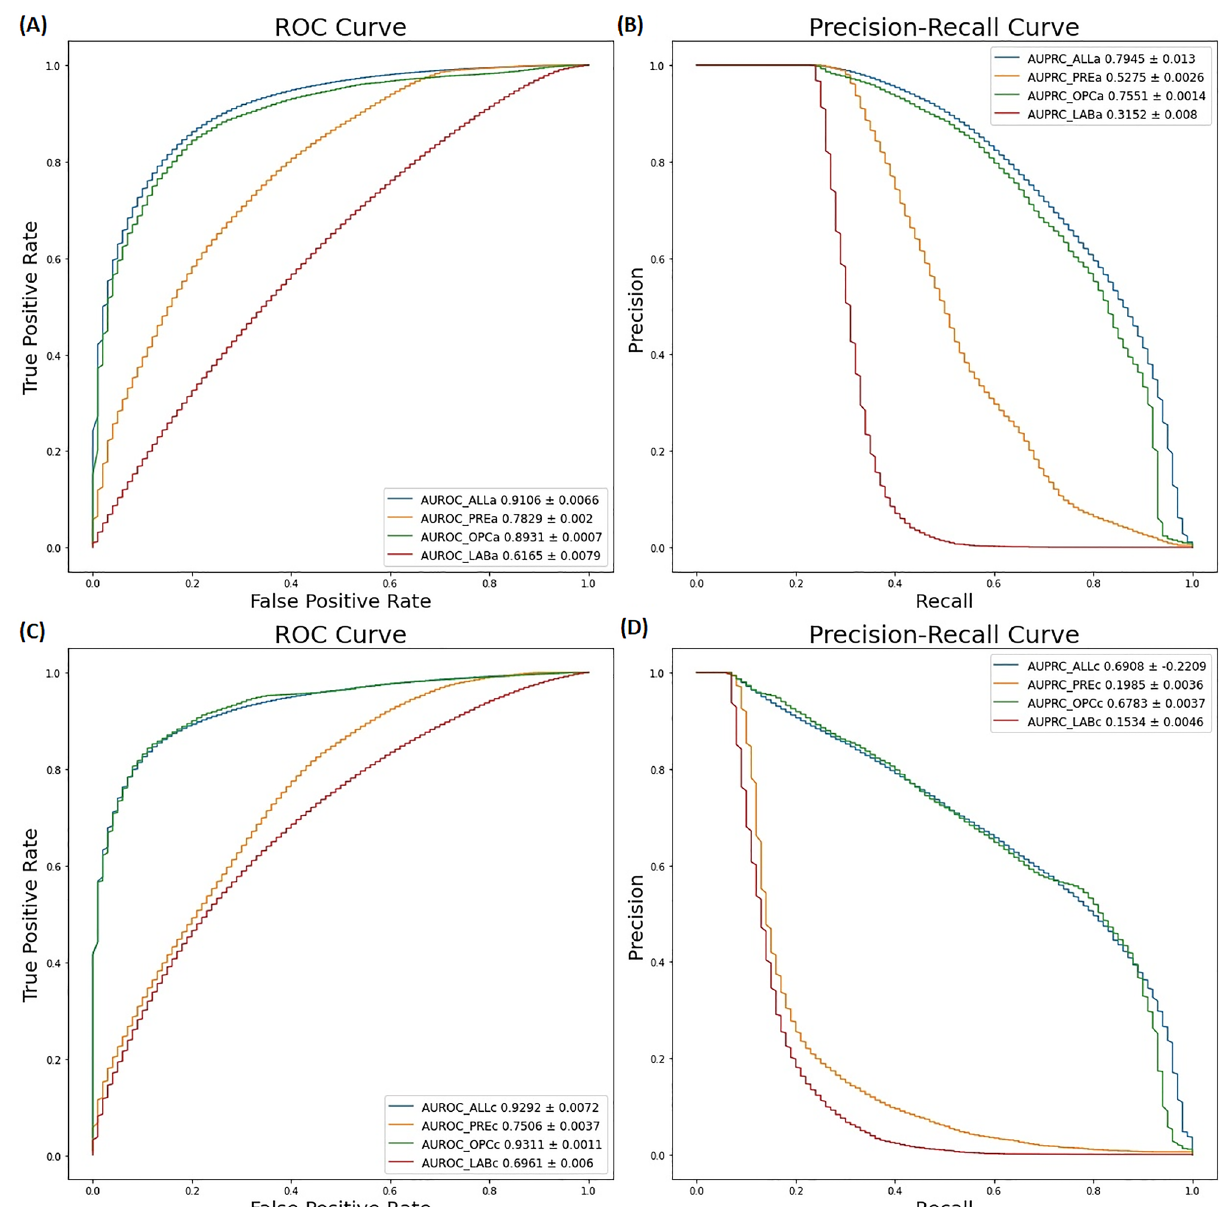
Figure 1. The predictive performance of the predictive models for several feature combinations using the deep learning method with 5 layers of deep neural network. ( A ) AUROC and ( B ) AUPRC of the predictive model for the preoperative decision on whether an arterial catheter is required during surgery. ( C ) AUROC and ( D ) AUPRC of the predictive model for the preoperative decision on whether a central venous catheter is required during surgery. AUROC and AUPRC values are represented as 95% confidence intervals. AUROC, area under receiver operating characteristic; AUPRC, area under precision-recall curve; DNN, deep neural network. ALLa, prediction for arterial catheterization using all variables; PREa, prediction for arterial catheterization using preoperative clinical data except for operation code and laboratory data; OPCa, prediction for arterial catheterization using operation codes; LABa, prediction for arterial catheterization using preoperative laboratory data; ALLc, prediction for central venous catheterization using all variables; PREc, prediction for central venous catheterization using preoperative clinical data except for operation code and laboratory data; OPCc, prediction for central venous catheterization using operation codes; LABc, prediction for central venous catheterization using preoperative laboratory